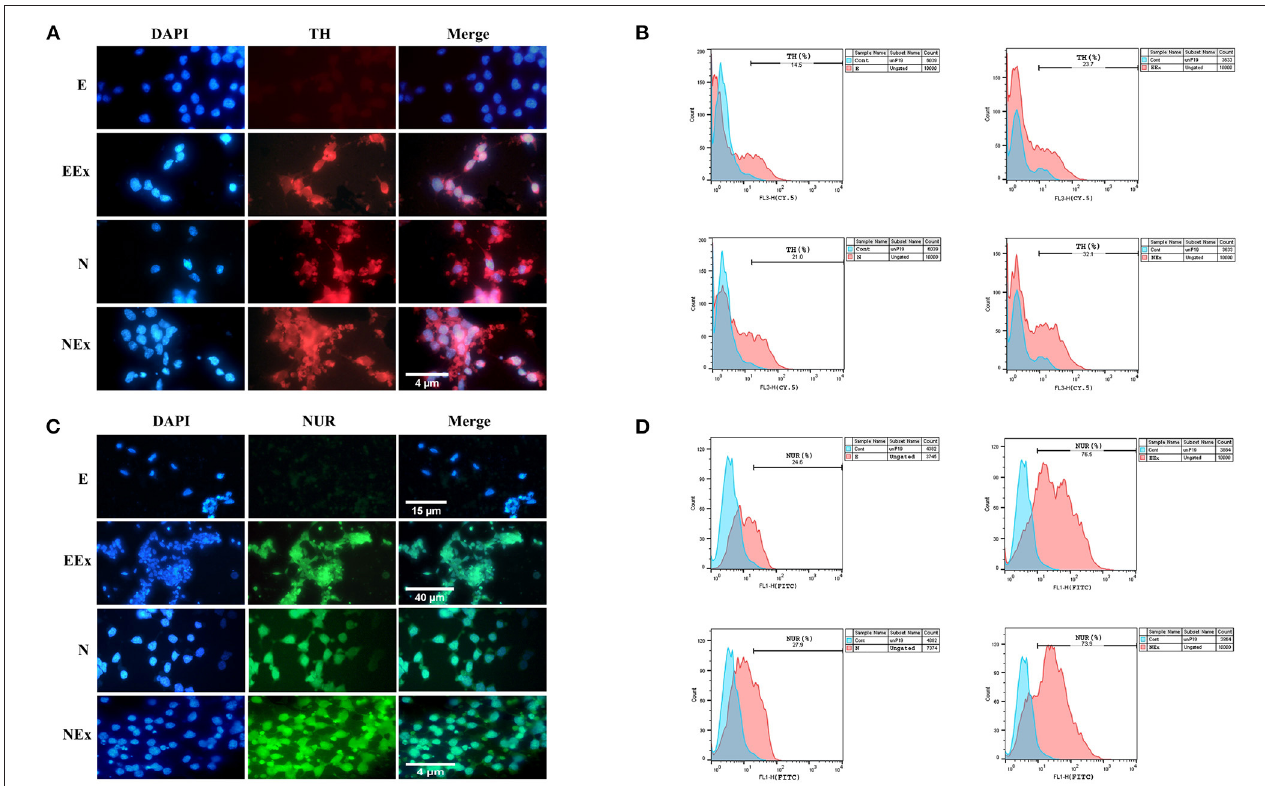
FIGURE 7 | Qualitative and quantitative assessment of dopaminergic specific proteins, tyrosine hydroxylase, and Nurr1 in the second week of the differentiation protocol. (A) The cells of all groups except E were immunoreactive to tyrosine hydroxylase. (B) Flow cytometry results showed a higher level of tyrosine hydroxylase protein in NEx, EEx, and N groups compared to the E group. (C) The cells of all groups except E were immunoreactive to Nurr1. (D) Flow cytometry results showed a higher level of Nurr1 protein in NEx, EEx, and N groups compared to the E group. DAPI was applied to counterstain the nuclei. TH, tyrosine hydroxylase; NUR, Nurr1; E (empty), EBs transfected with pCMV3-GFPSpark vector; EEx (empty/extract), EBs transfected with pCMV3-GFPSpark vector and treated by extract; N (Nurr), EBs transfected with pCMV3-NR4A2-GFPSpark vector; NEx (Nurr/extract), EBs transfected with pCMV3-NR4A2-GFPSpark vector and treated by